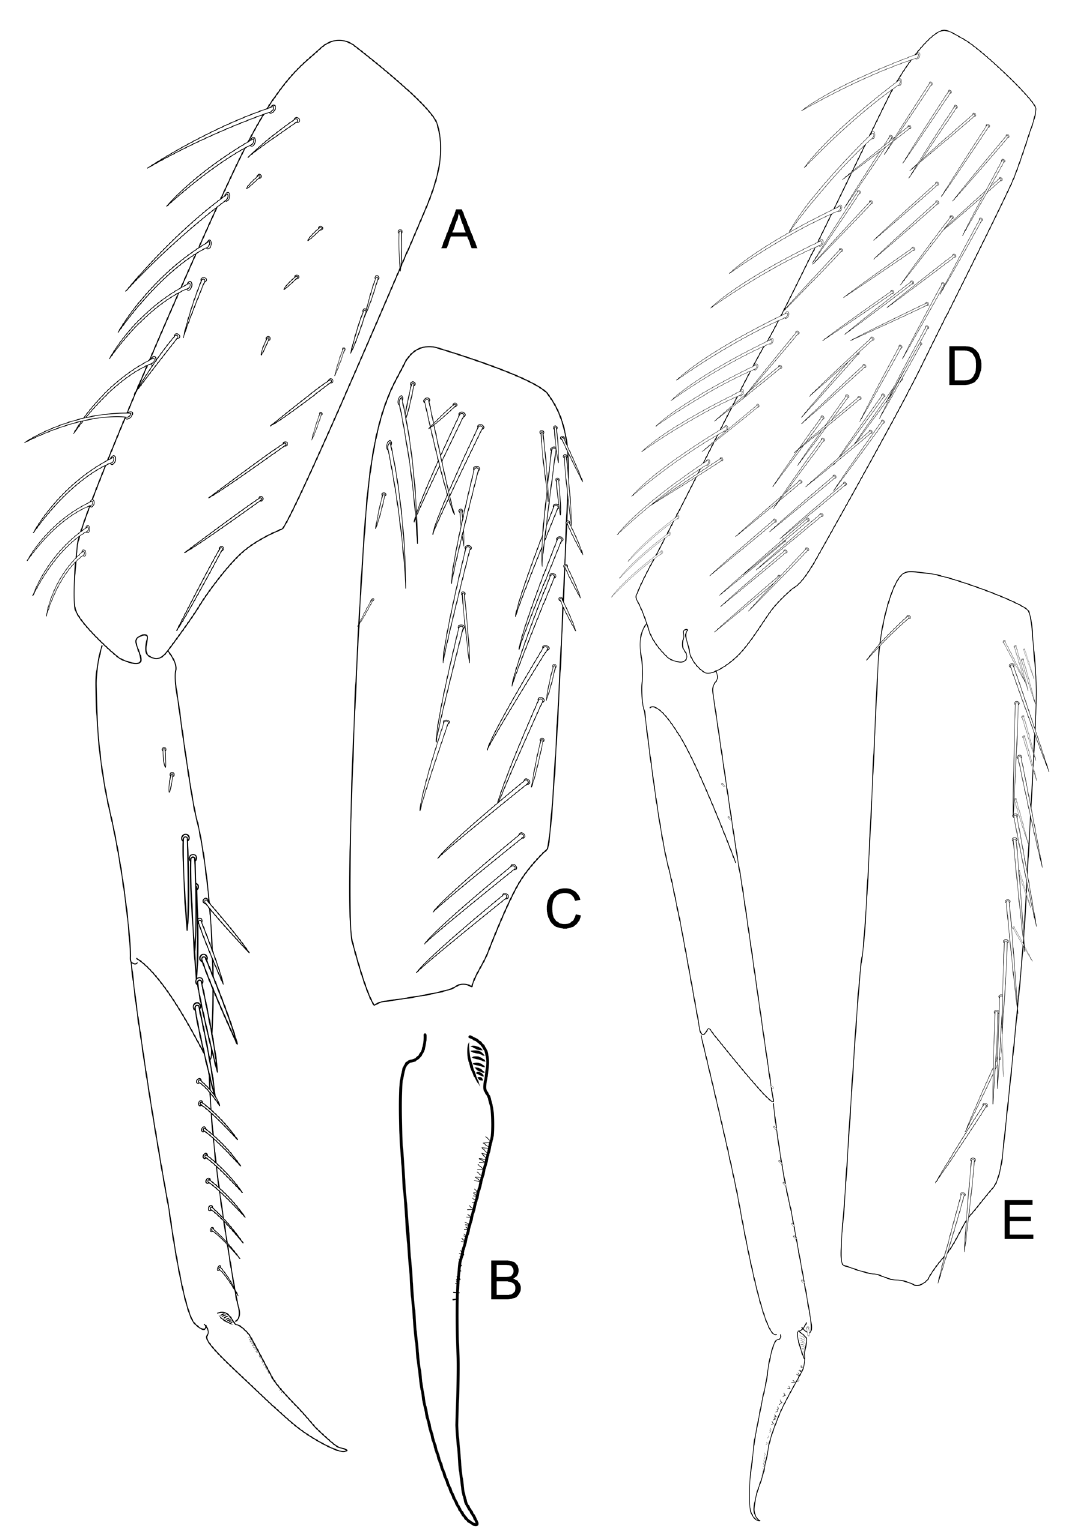
Fig. 9. Rivudiva oxum sp. nov., holotype (INPA). A . Foreleg (femur on anterior surface). B . Details of fore claw. C . Posterior surface of forefemur. D . Hind leg (femur on anterior surface). E . Posterior surface of hind femur. Not to